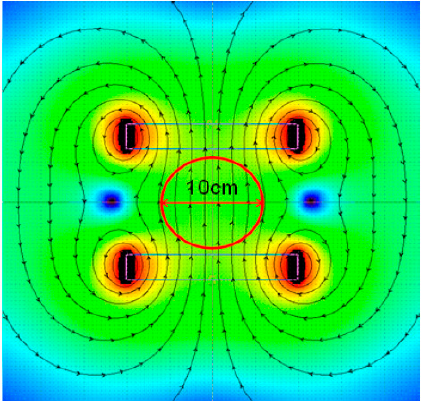
Figure 1. Distribution of the permanent magnetic field with induction B = 100 mT, within the sample extract.